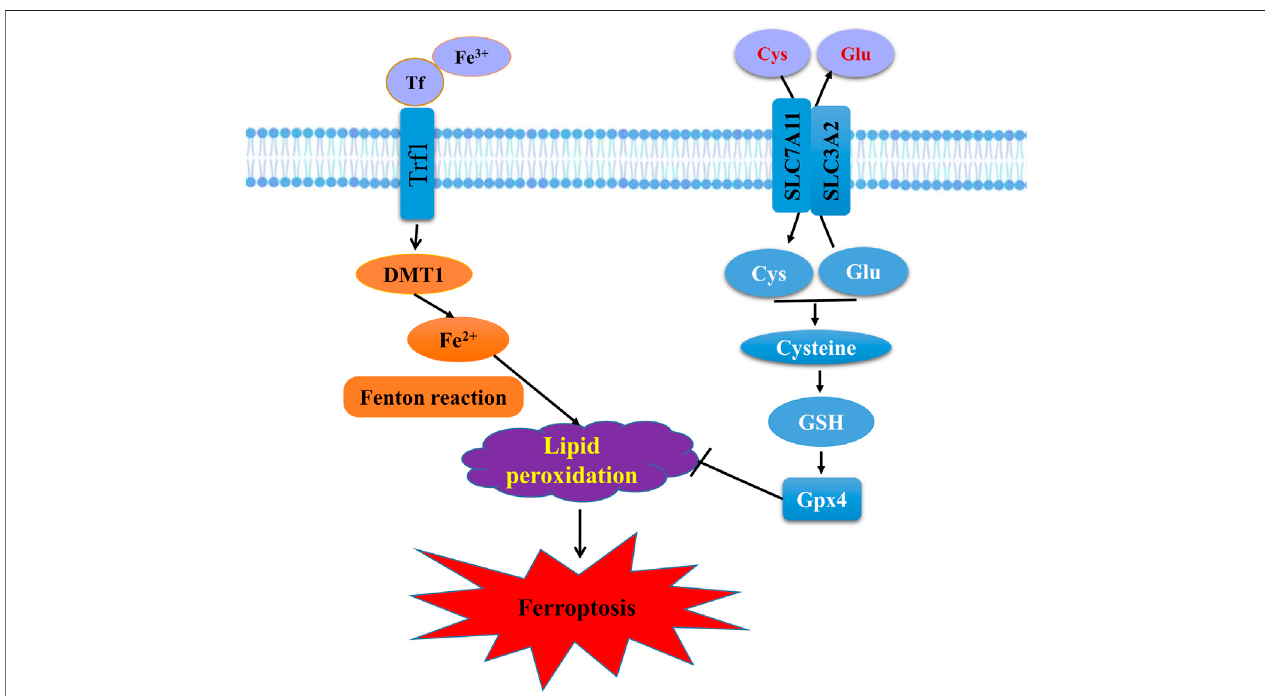
FIGURE3| Schematicrepresentationofthemechanismofferroptosis.Ferroptosisisaniron-dependentformofregulatedcelldeathmediatedbyironoverloadand lipid peroxidation of cellular membranes. Fe 3+ imported through the transferrin receptor is converted to Fe 2+ in endosomes and released from endosome by divalent metal-ion transporter 1 (DMT1). Fenton reaction converts Fe 2+ into Fe 3+ , which induces lipid peroxidation. GPX4 is the major endogenous mechanism to suppress lipid peroxidation. High extracellular concentrations of glutamate (Glu) inhibit system X c − , which imports cystine (Cys) by exchanging intracellular Glu for extracellular Cys. Cys is subsequently converted to cysteine, which generates GSH, a cofactor for GPX4.